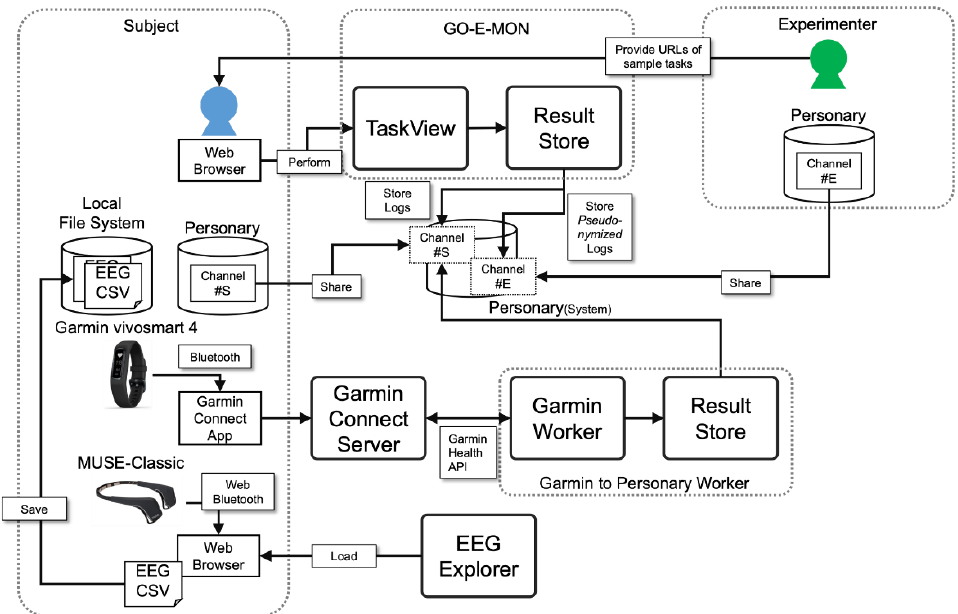
Figure 4. Data flow of the sample tasks: the experimental data of each task created by GO-E-MON and various measurement data by Garmin vivosmart 4 are stored in the subject’s Personary account, and the EEG data generated by the MUSE-Classic is stored in the local file system.